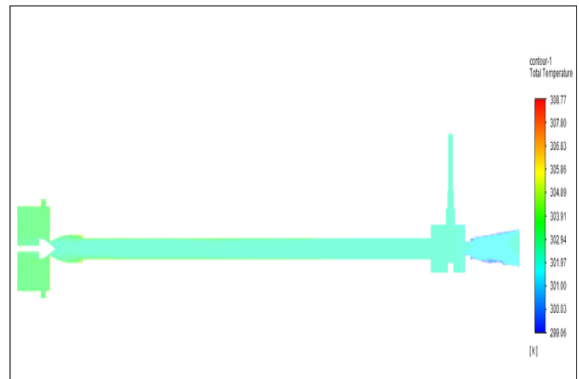
Figure 38. CPVC at 10 bar.